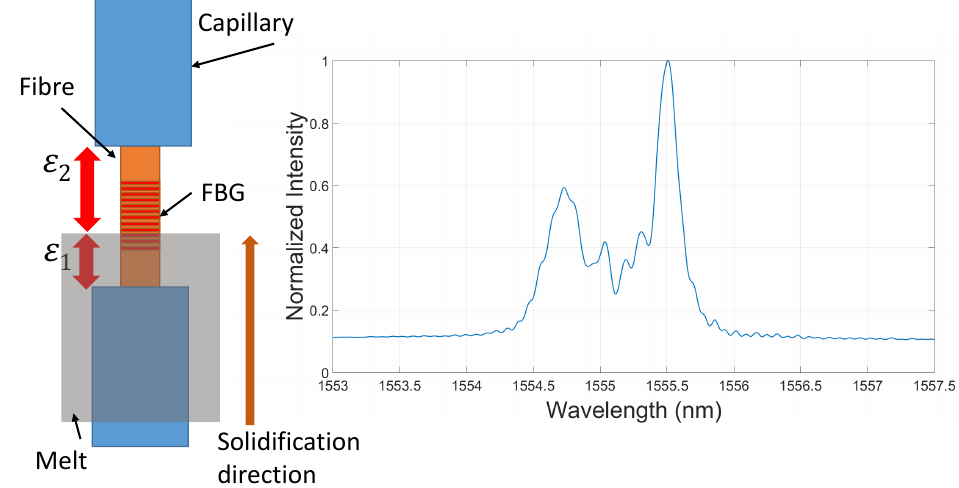
Figure 15. Deformation of the reflected spectra due to the influence of different strains along the